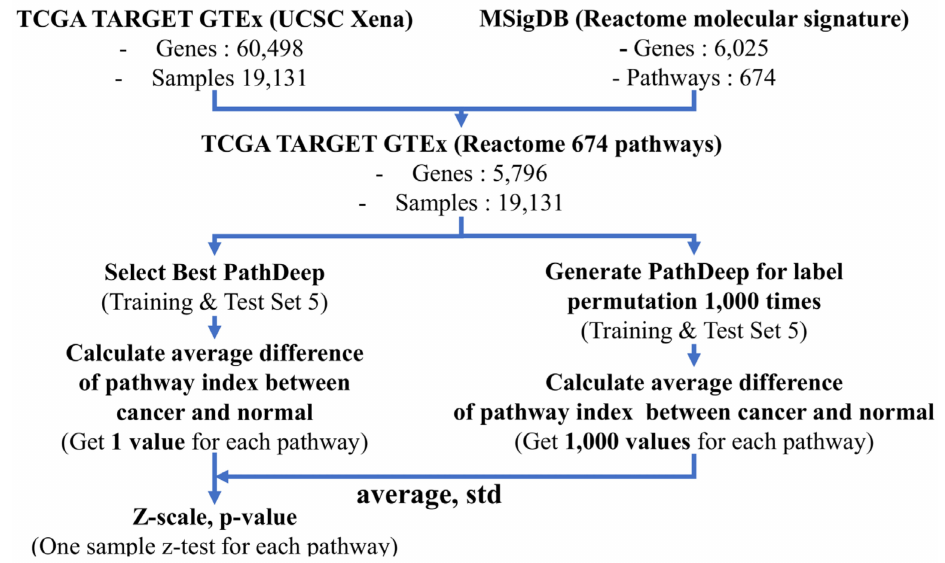
Figure 8. Workflow of the PathDeep label permutation study for identifying cancer-related pathways.